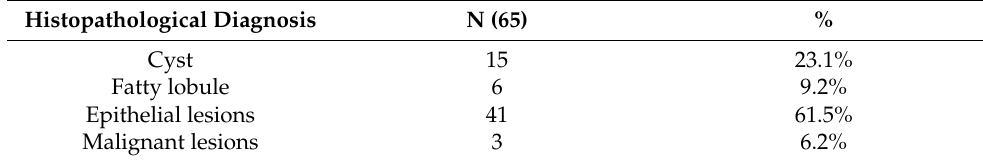
Table 1. Histopathological findings of the 65 lesions.